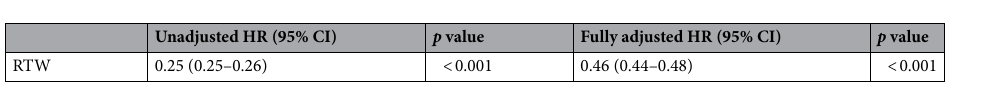
Table 3. Associations between returning to work and all-cause mortality. Adjusted covariates: age, treatment, income range, industrial classification, company size, cancer stage, return to